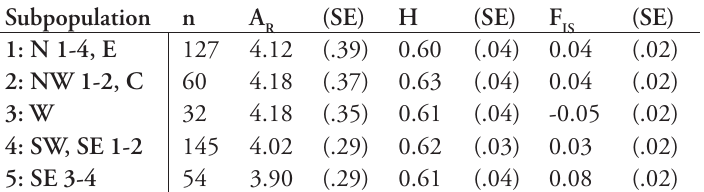
Table 3. Genetic variation in the five identified Norwegian red deer sub- populations ( n = 419, the involved locations also given, see Fig 1), each ), unbiased gene diversity (H) represented by estimates of allelic richness (A R and inbreeding (F ) averaged across loci. Standard errors in brackets is